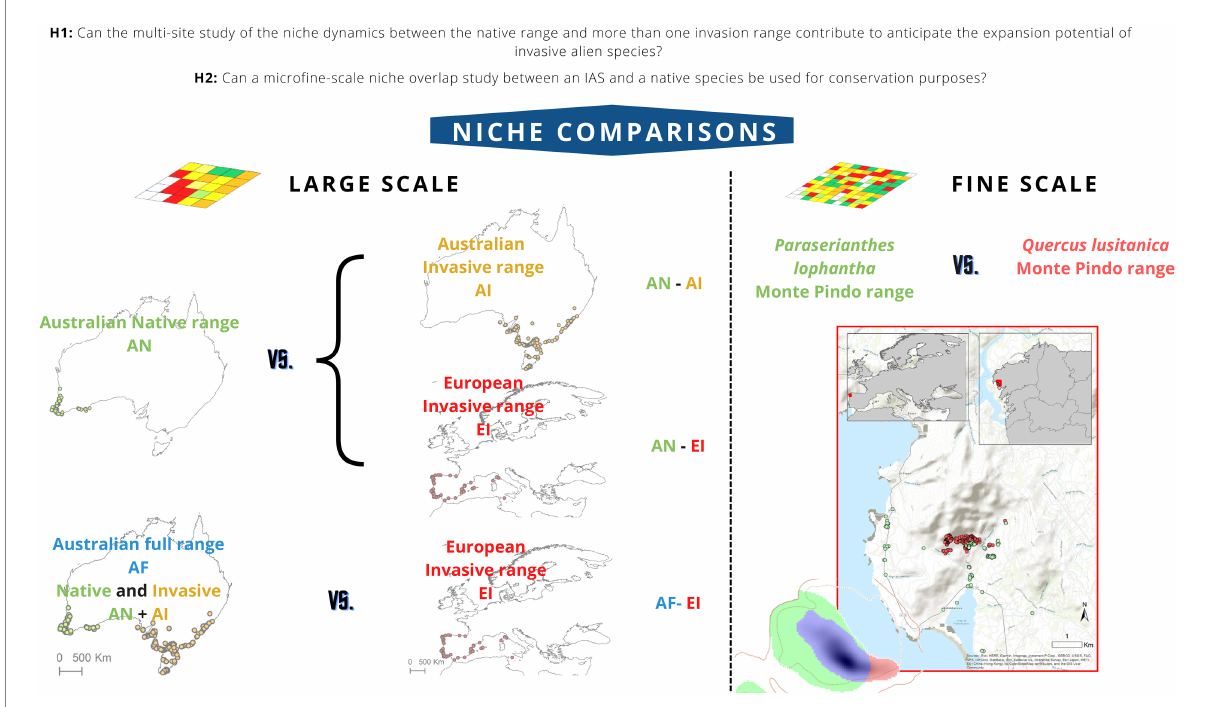
FIGURE 1 Niche comparisons performed in this work. The large-scale study of Paraserianthes lophantha macroclimatic niche dynamics involves a comparison between niches from its Australian native range and its Australian invasive range (AN-AI comparison) niches from its Australian native range and its European invasive range (AN-EI) niches from its full Australian range (native and invasive) and its European invasive range (AF-EI). The fine-scale study of niche overlap between P. lophantha and Quercus lusitanica involves comparisons between the niches occupied by both species in the local area of Monte Pindo. Fine-scale study of niche overlap between P. lophantha and Quercus lusitanica in Monte Pindo. Solid and dotted contour lines represent 100 and 50% of the available environmental conditions that exist in available environment in Monte Pindo. Green areas represent climates only occupied by P. lophantha , blue areas indicate climates occupied both by the native Q. lusitanica and the introduced P. lophantha , red areas represent climates only occupied by Q. lusitanica . Shading indicates the density of